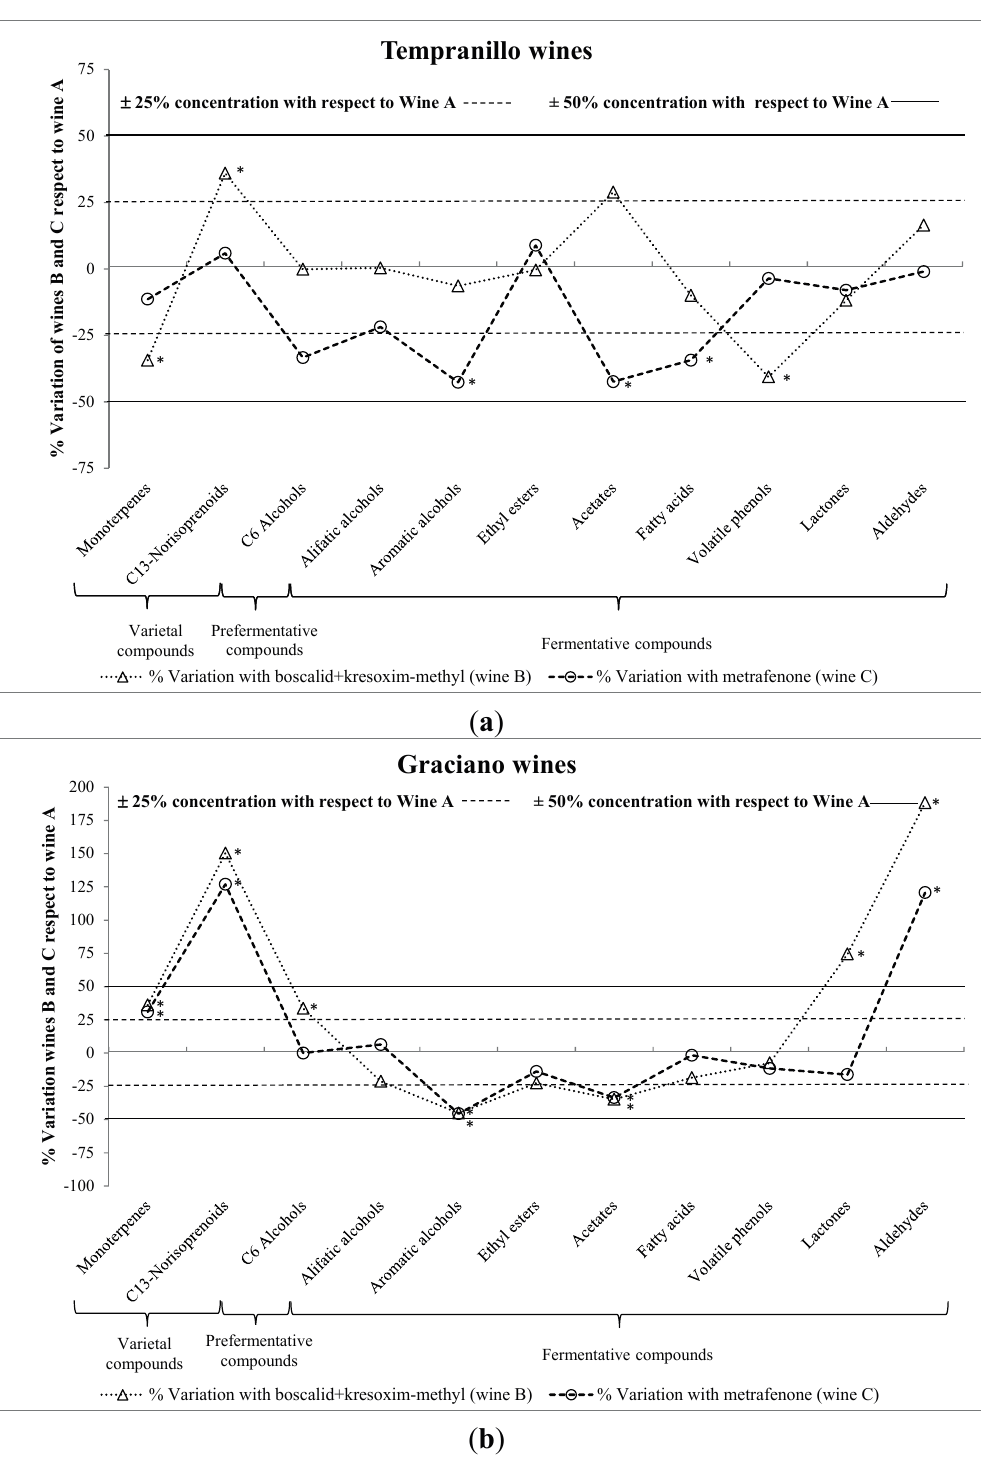
Figure 1. Percentages of variation with respect to control wine (A) on the total concentrations of volatile compounds: Tempranillo-based wines ( a ) and Graciano-based wines ( b ). Significant differences at p < 0.01 (Fisher’s least significant difference test) with respect to control wines were pointed out with an asterisk ( *